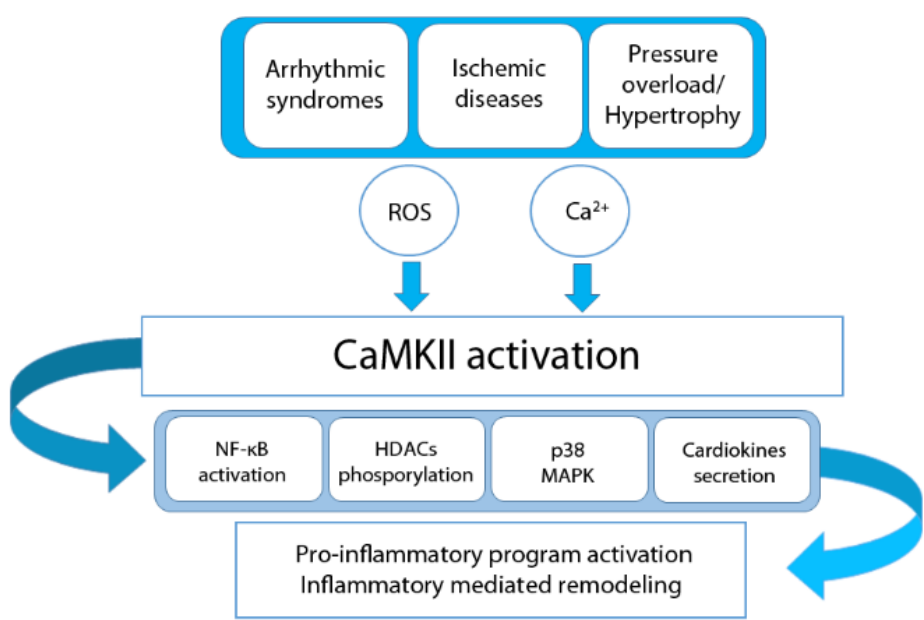
Figure 1. Schematic description of Calcium/calmodulin-dependent (CaMK) II involvment in the inflammatory response in cardiac diseases.